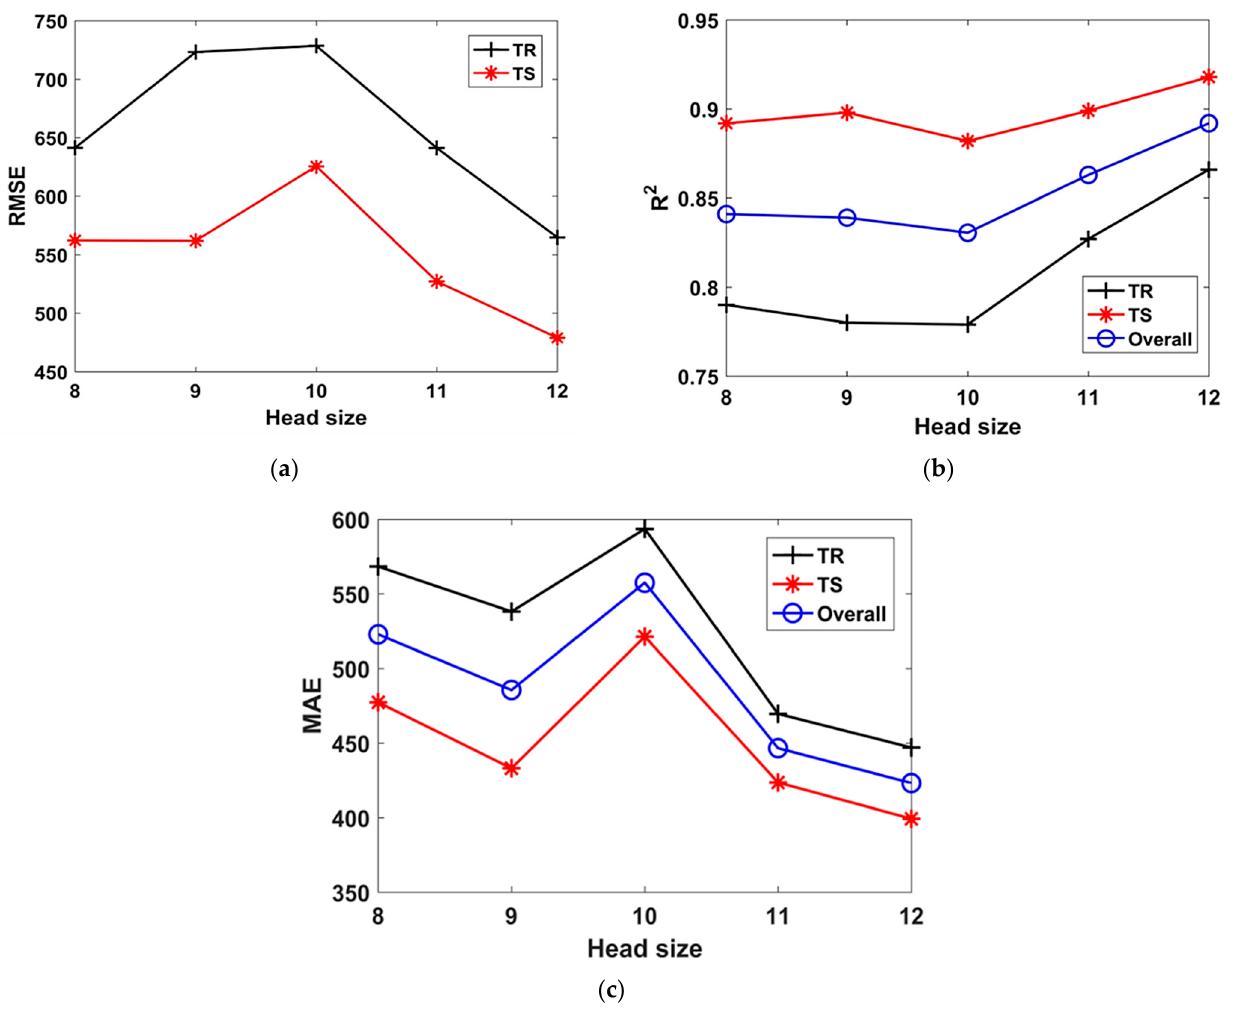
Figure 4. Effect of number of genes on the performance of models. ( a ) R 2 , ( b ) RMSE, ( c ) MAE.